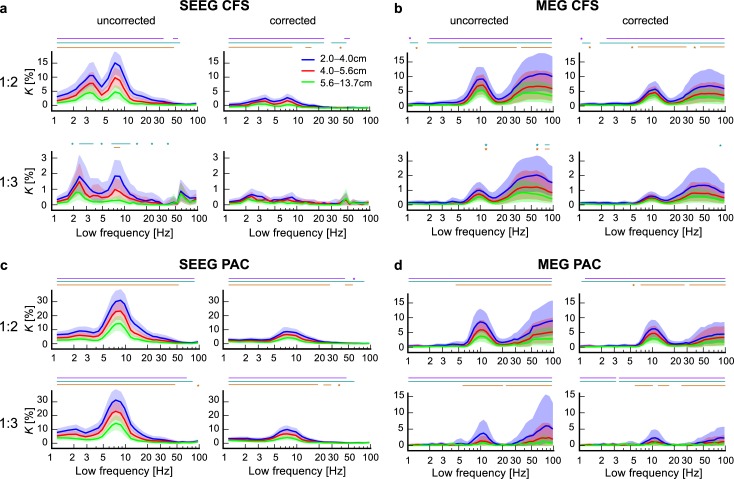
Interareal CFS and PAC decrease as a function of distance.(a) Connection density (K) for uncorrected (left) and corrected (right) interareal CFS estimated separately in 3 distance bins containing equal numbers of connections for 1:2 (top row) and 1:3 (bottom row) interareal CFS in SEEG data. All values are plotted, with 95% confidence limits indicated by shades. The colored bars and stars indicate LFs where K values between distance bins were significantly different (Wilcoxon test, p < 0.05, corrected) between distance bins (purple: short versus medium; turquoise: short versus long; orange: medium versus long). (b) Same as (a) for CFS in MEG. (c) Same as (a) for interareal PAC in SEEG and (d) in MEG. Connection density of CFC was larger for the shortest than for the longest distance bin for CFS at ratio 1:2 and for PAC at ratios 1:2 and 1:3 in both SEEG and in MEG data across most of the frequency spectrum. Plot data and underlying connectome data are available online at https://datadryad.org/stash/dataset/doi:10.5061/dryad.0k86k80. CFC, cross-frequency coupling; CFS, cross-frequency PS; LF, low frequency; MEG, magnetoencephalography; PAC, phase–amplitude coupling; PS, phase synchrony; SEEG, stereoelectroencephalography.